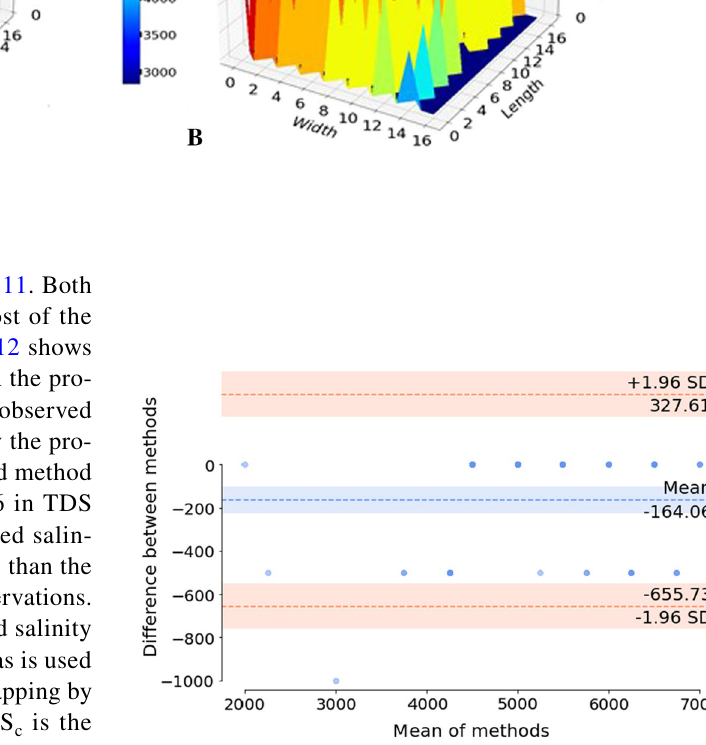
Fig. 12 Bland Altman difference plot for TDS